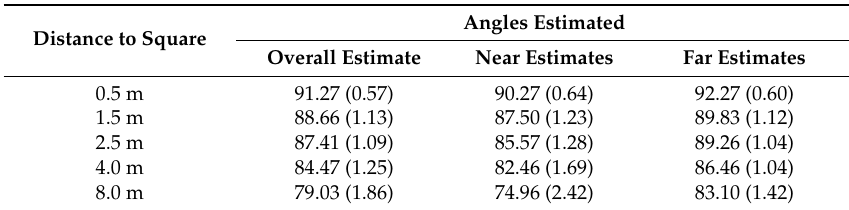
Table 1. Means and standard errors (in parentheses) for angles estimates as a function of distance both overall and separately for near vs. far location.